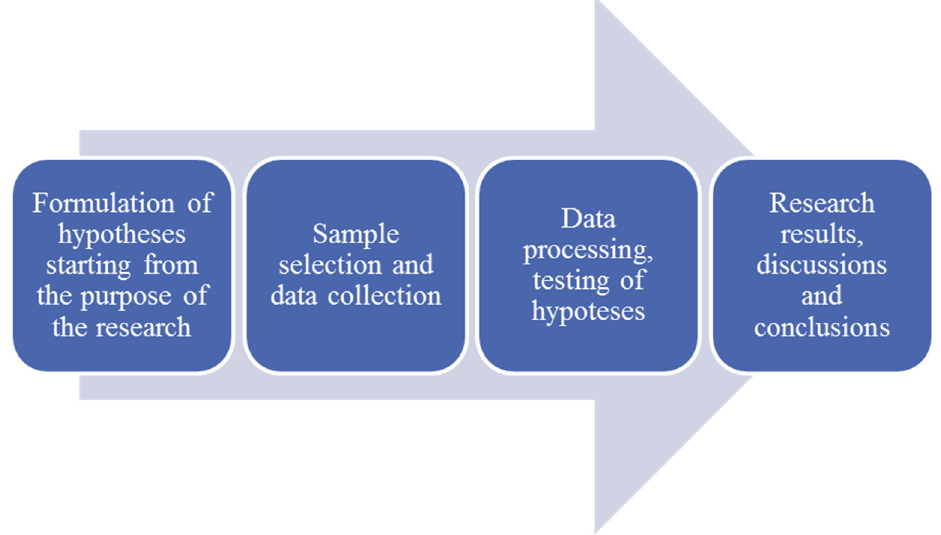
Figure 1. Research process. Source: own construction.